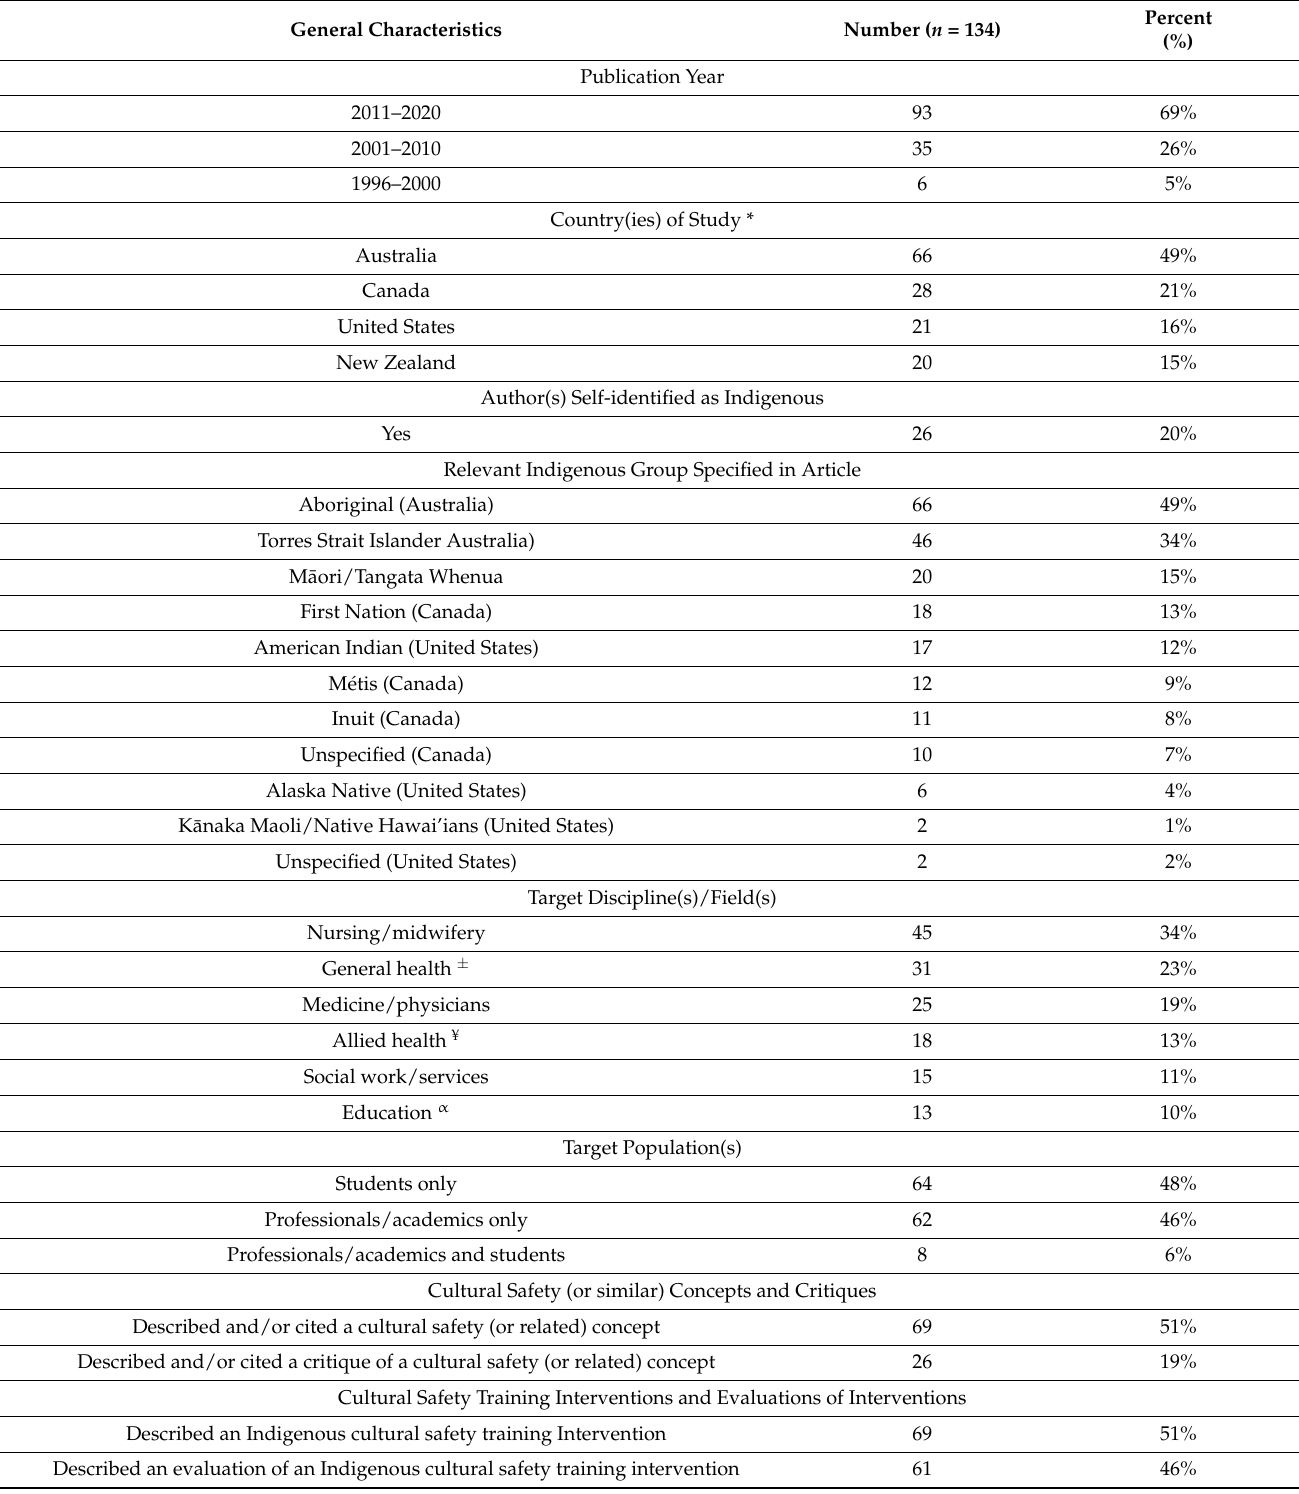
Table 2. General Characteristics of Sources of